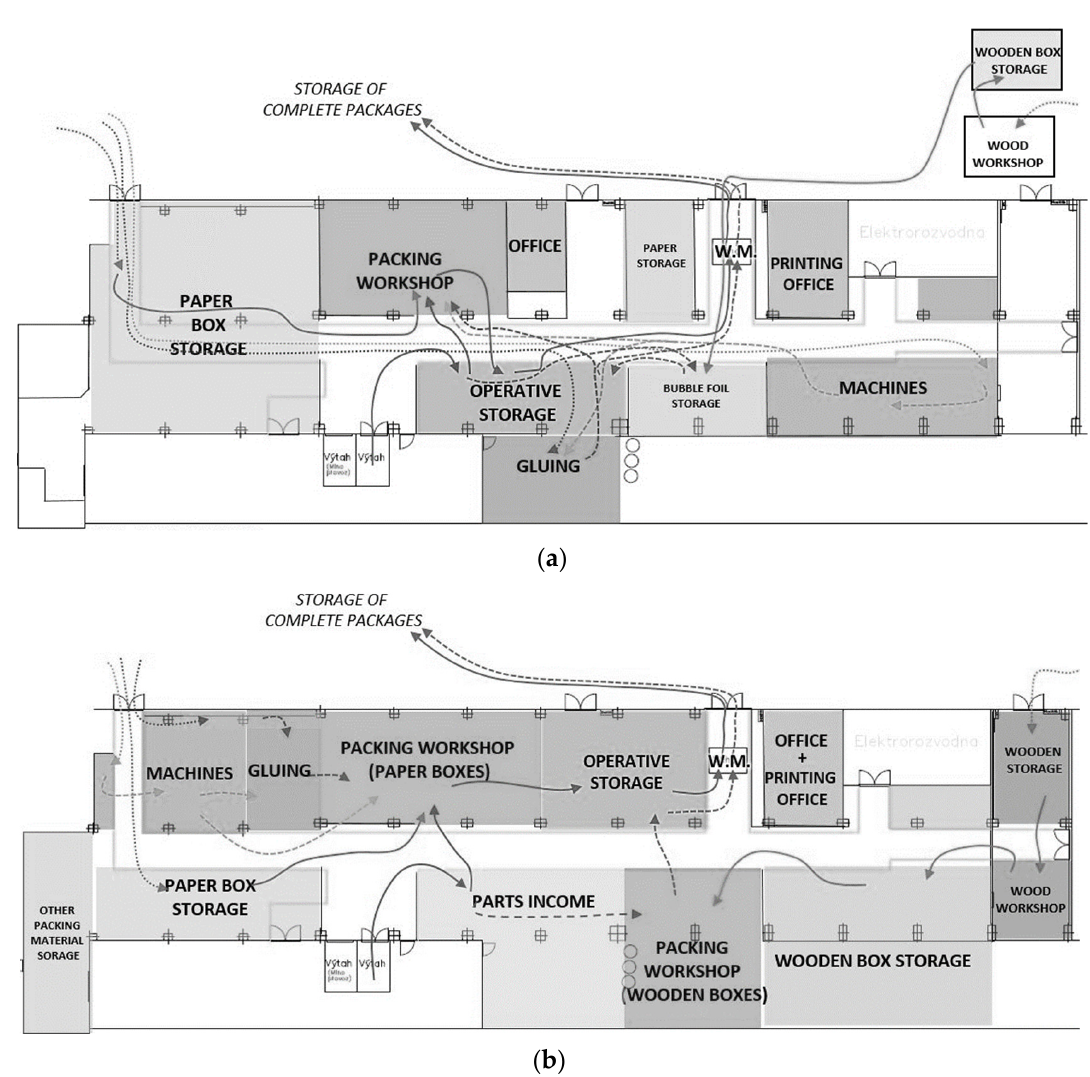
Figure 2. Material flows of packing process: ( a ) original state; ( b ) improved state [50].